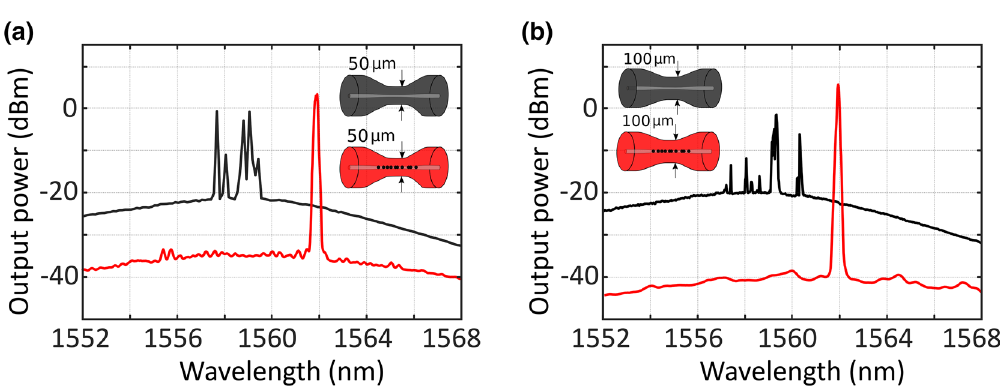
Figure 8. ( a ) Output spectra of the short-linear-cavity fiber laser, pumped by a 1445-nm light at 500 mW and using an un-drilled (black line) or a micro-drilled (red line) 50 µm-waist tapered fiber. ( b ) Output spectra of the short-linear-cavity fiber laser, pumped by a 1445-nm light at 500 mW and using an un-drilled (black line) or a micro-drilled (red line) 100 µm-waist tapered